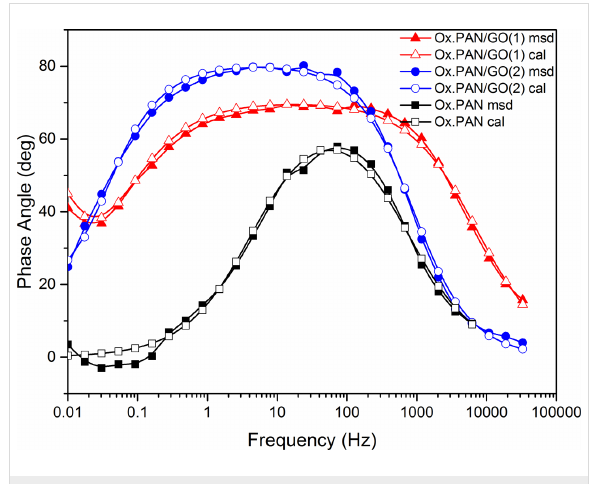
Figure 13: Bode phase plots of oxidized PAN nanofiber webs and GO-containing oxidized PAN nanofiber webs.